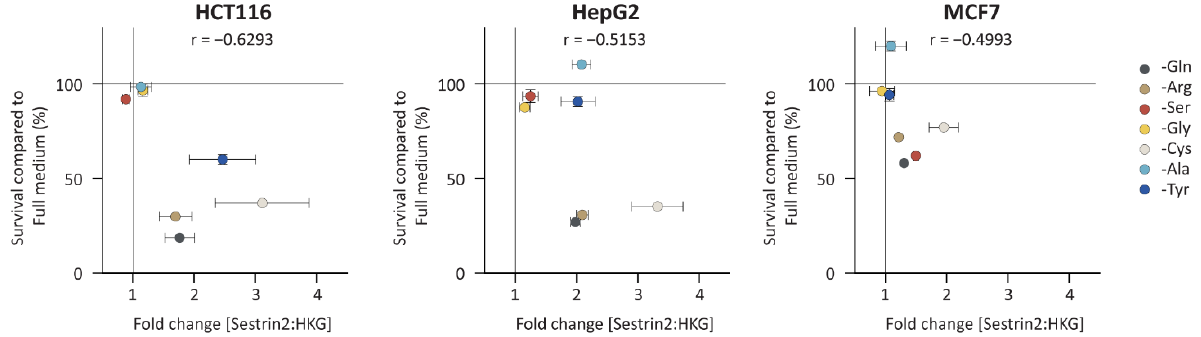
Figure 2. Negative correlation between Sestrin2 expression and cellular survival. Sestrin2 levels from three independent experiments were plotted on the xaxis; yaxis shows cellular survival measured with SRB assay. Pearson correlation was calculated and r value is indicated for each graph. p values are 0.13, 0.2366, and 0.2539 for HCT116, HepG2, and MCF7, respectively.